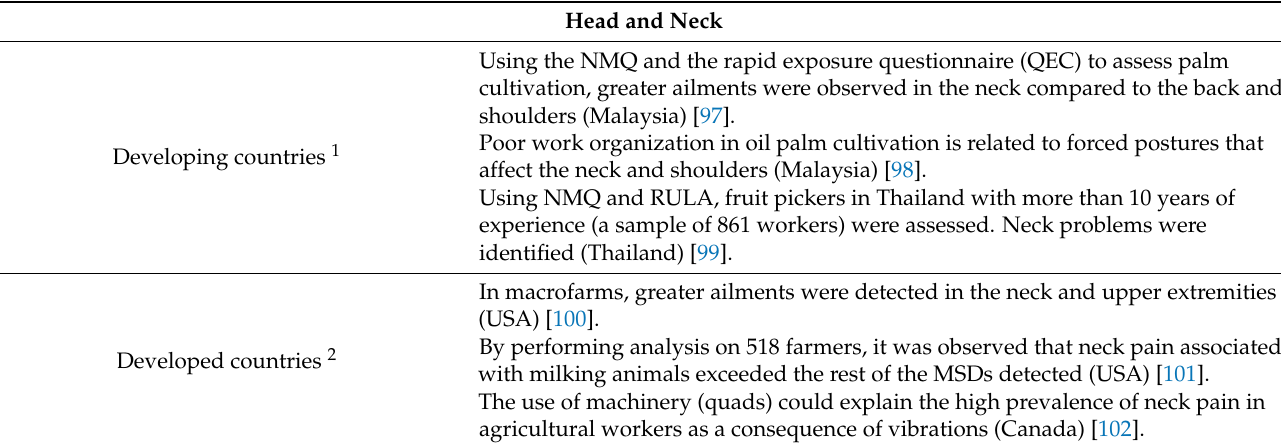
Table A2. MSD research in agriculture (1995–2020). Category: Head and neck. Head and Neck